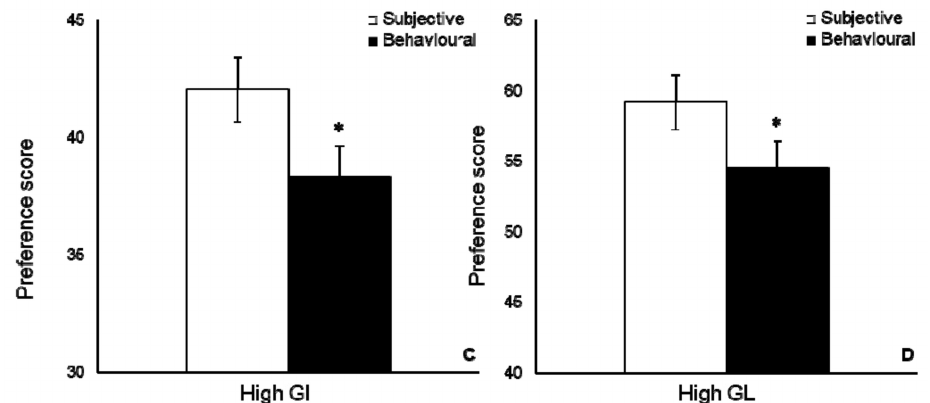
Figure 1. Subjective and self-reported behavioural preference. Preference score for Total Score Inventory (TIS) ( A ), foods high in sugar ( B ), foods with high GI ( C ), and foods with high GL ( D ). Behavioural = Self-reported behavioural. Data is presented as mean ± s.e.m. * Significant p < 0.01.